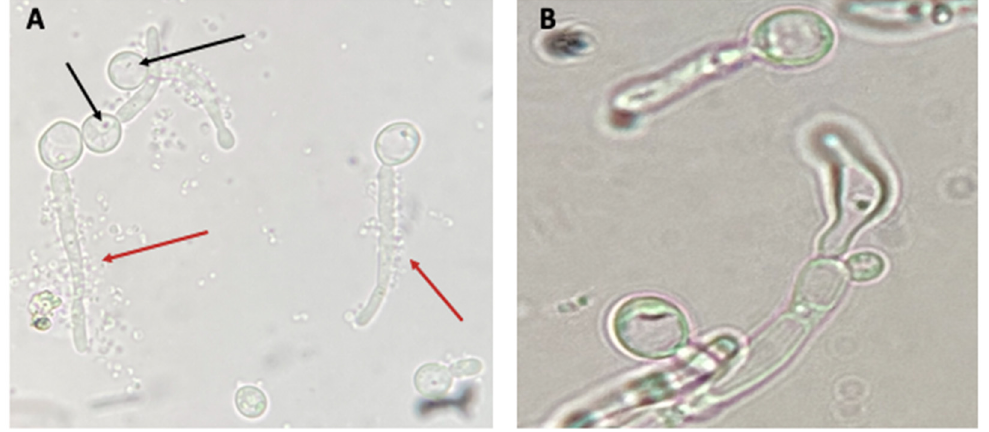
Figure 5. ( A ) Wet mount of H. pylori H707– C. albicans VT-3 24 h co-culture in BB-1%FBS showing Y-BLBs (black arrows) and H. pylori cells attached to pseudohyphae (red arrows). ( B ) Wet mount of C. albicans VT-3 cells from a pure culture (negative control) showing the absence of Y-BLBs. Movement of BLBs within yeasts is shown in Video S1. BB-1%FBS: Brucella broth supplemented with 1% of fetal bovine serum.